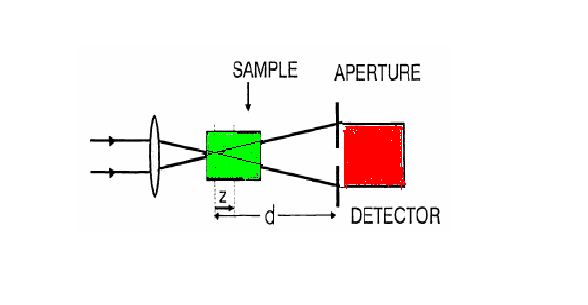
Fig.1: Schematic of the limiting geometry where Z is the distance between the focal plane in free space and the center of the sample, and d is the distance from this plane to the aperture